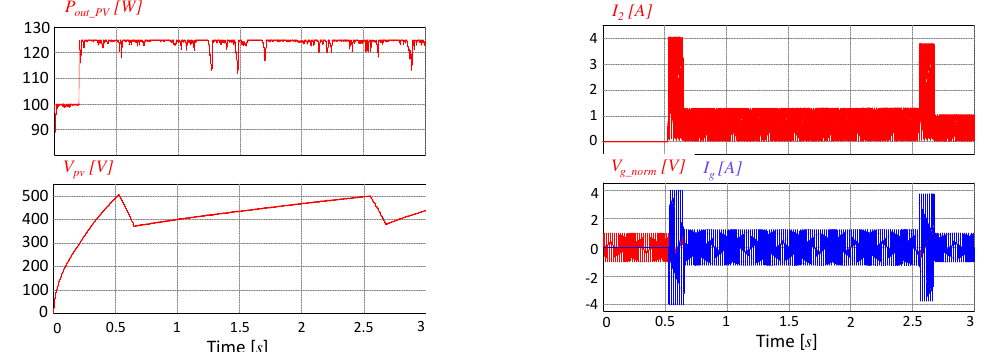
Figure 21. Injection of current into the grid—the power harvested from the solar panel P out _ PV ; the voltage in the capacitor C pv , V pv ; the current in the inductor L 2 , I 2 and the voltage and current of the grid V grid and I grid respectively.